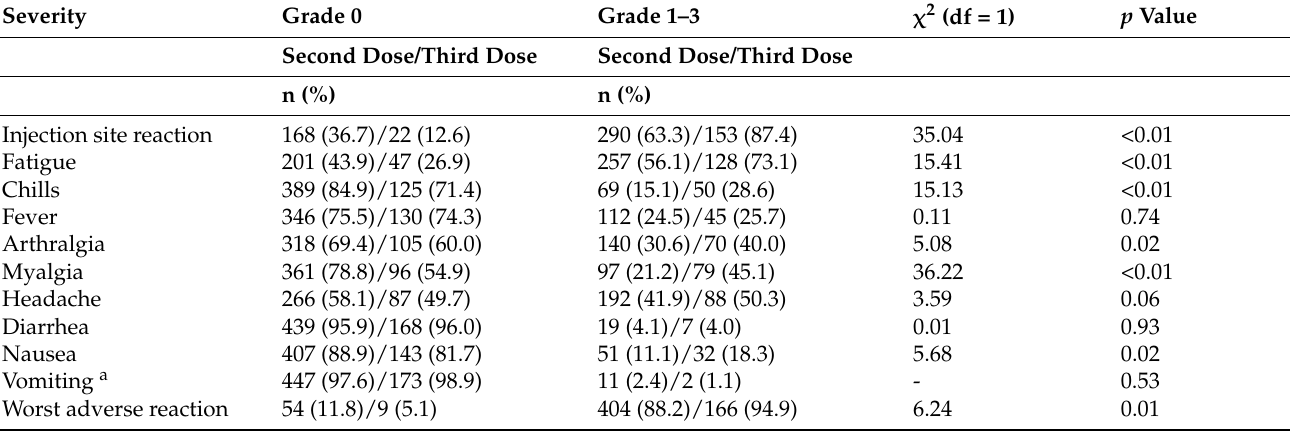
Table 3. Occurrence of adverse reactions in the second and third doses of BNT162b2